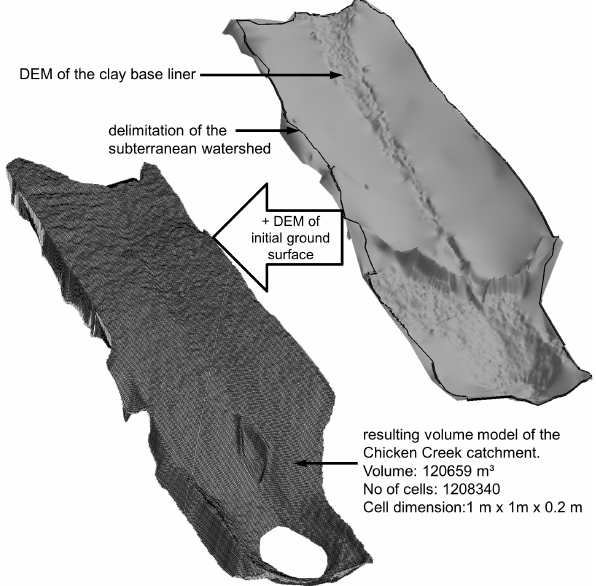
Fig. 7. From surface to volume body: the DEM of the clay base liner, which was constructed from photogrammetric and borehole data; was used together with the DEM of the initial ground surface to construct a volume body (Stratigraphic Grid, SGrid) in